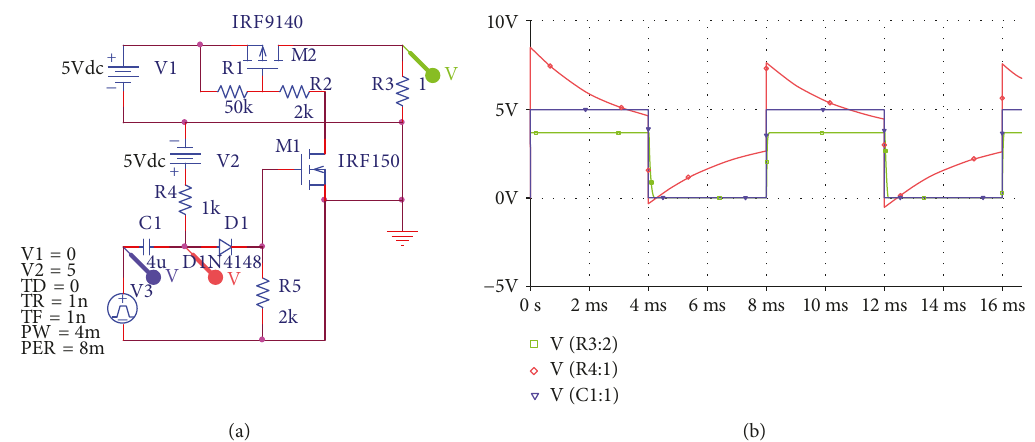
Figure 6: Latch-up protection simulation (a) circuit and (b) waveforms.